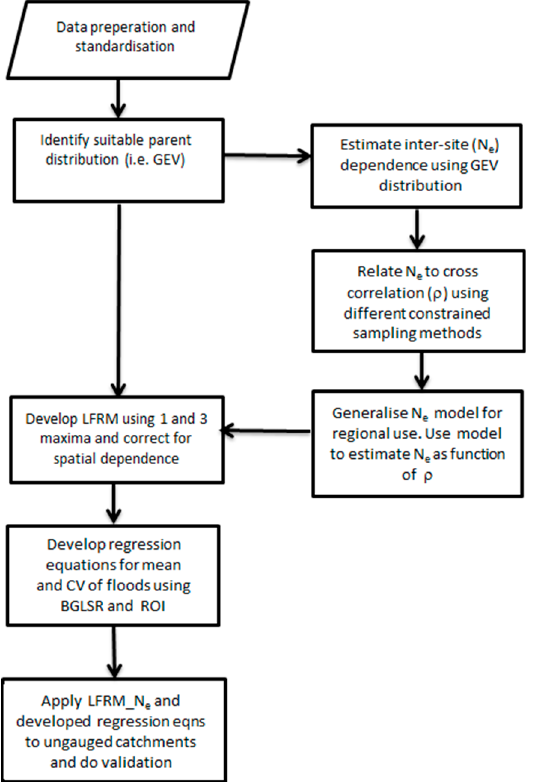
Figure 3. Flowchart with the different methods described in the methodology.